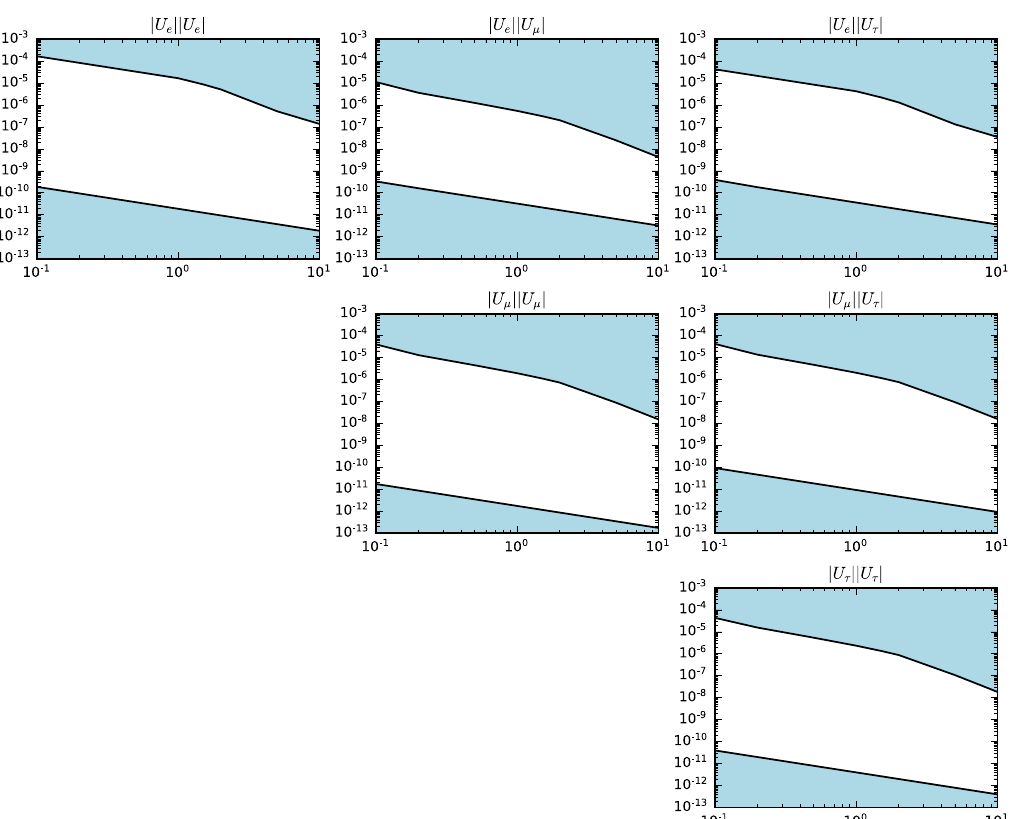
2 and products . U α U α U β | | | |·| |